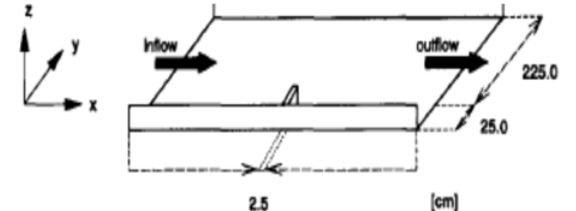
Fig.1 Flow configuration around the groyne (Holtz,